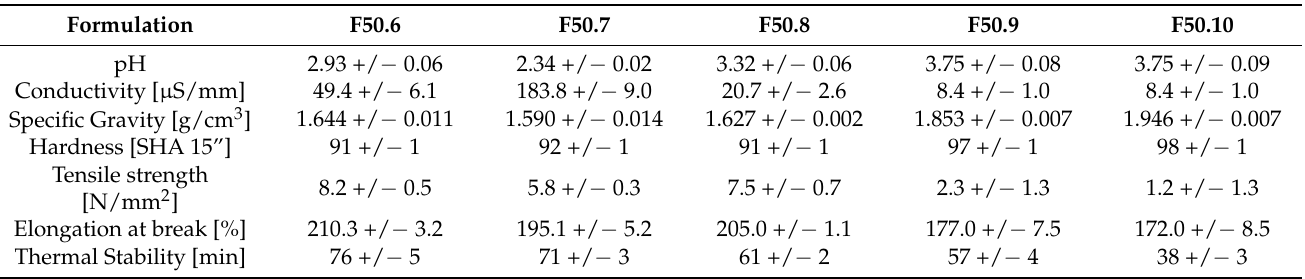
Table 12. Second series of formulations. Main properties of the compound. Mean values and SD are reported.